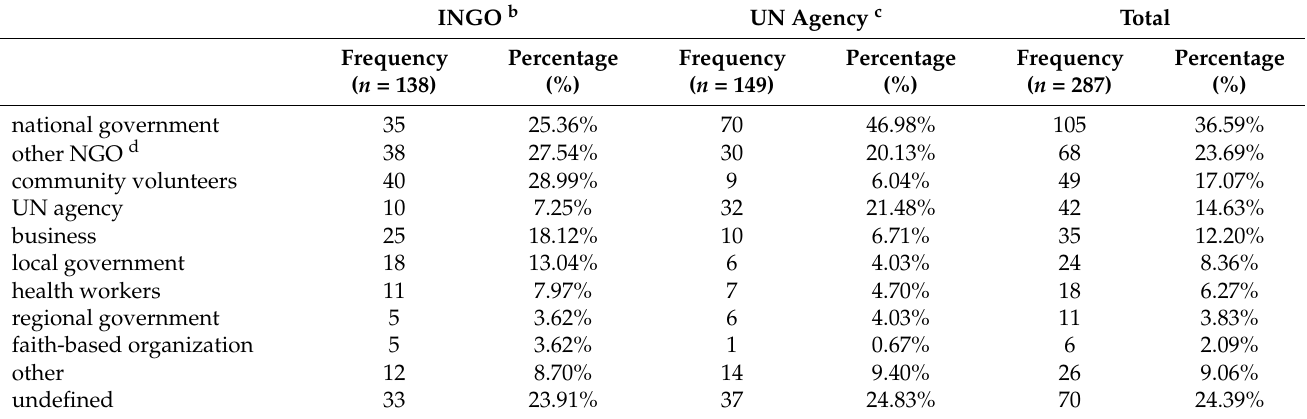
Table 6. Partnerships involved in food security interventions implemented by INGOs and UN agencies in response to the COVID-19 pandemic in low- and middle-income countries from 31 December 2019 to 31 May 2020 ( n = 287) a